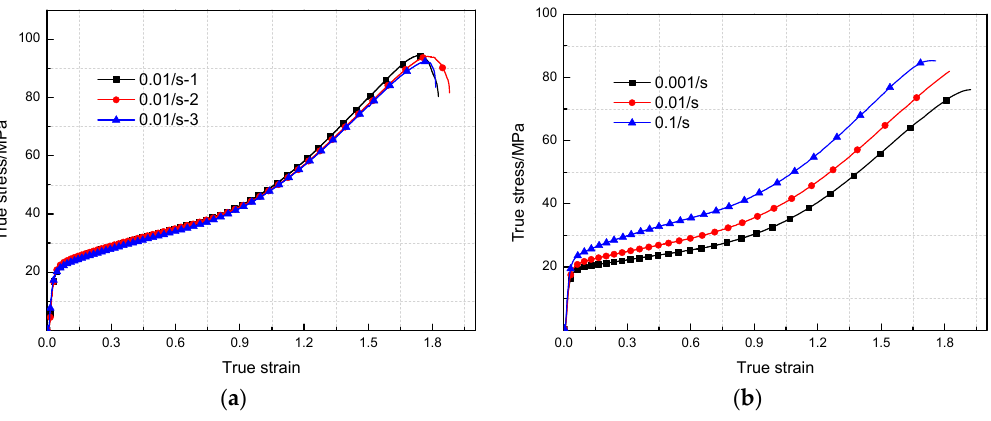
Figure 7. True stress-strain curves of PTFE/Al/MoO 3 specimens under quasi-static compression. ( a ) Strain rate 10 − 3 s − 1 ; ( b ) Strain rate 10 − 3 ~10 − 1 s − 1 . Table 1. Mechanical properties parameters of PTFE/Al/MoO 3 specimens. (under quasi-static compression). Strain Rate/s −